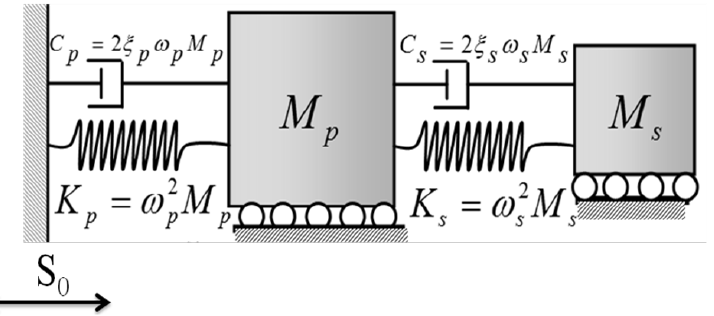
Fig. 1. Two-degree of freedom dynamic